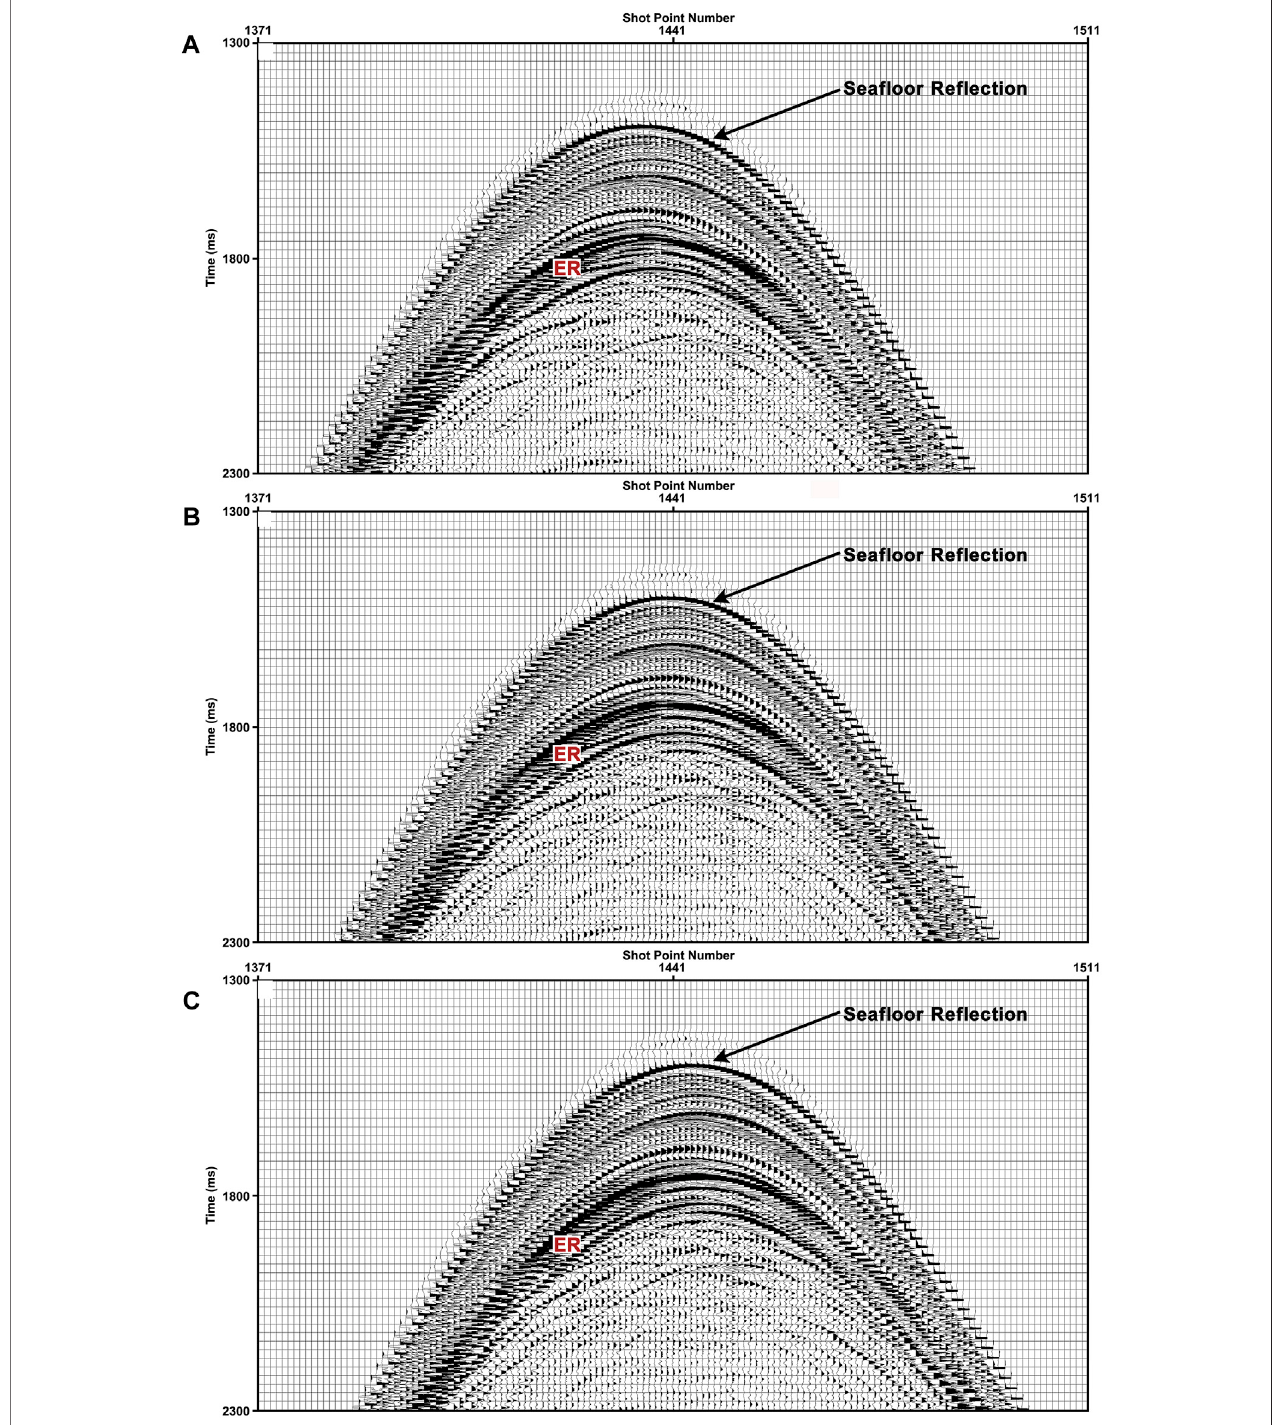
FIGURE 7 | The CSP gathers. (A) CSP 165. (B) CSP 180. (C) CSP 195.